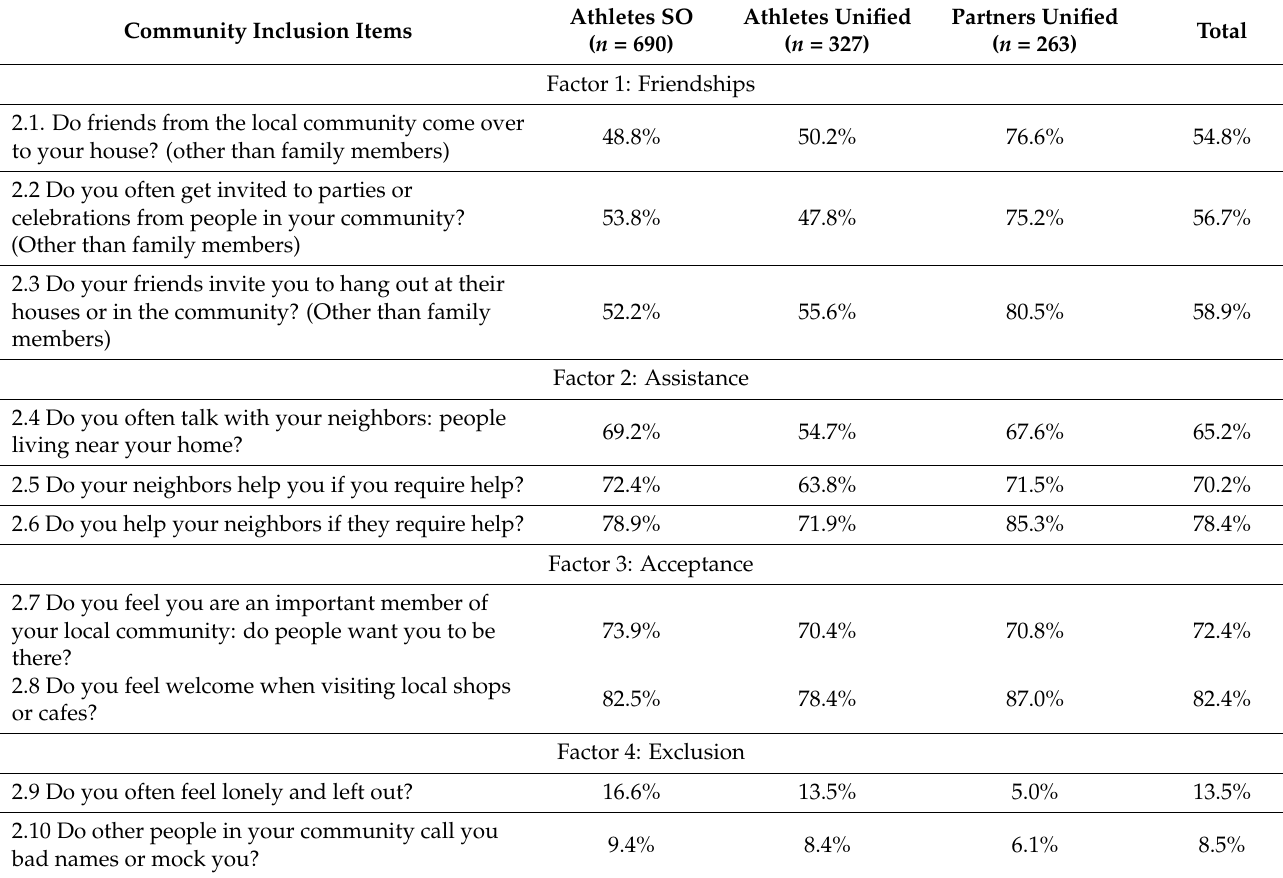
Table 5. The percentage of athletes and partners answering Yes to the Community Inclusion Items. Community Inclusion Items